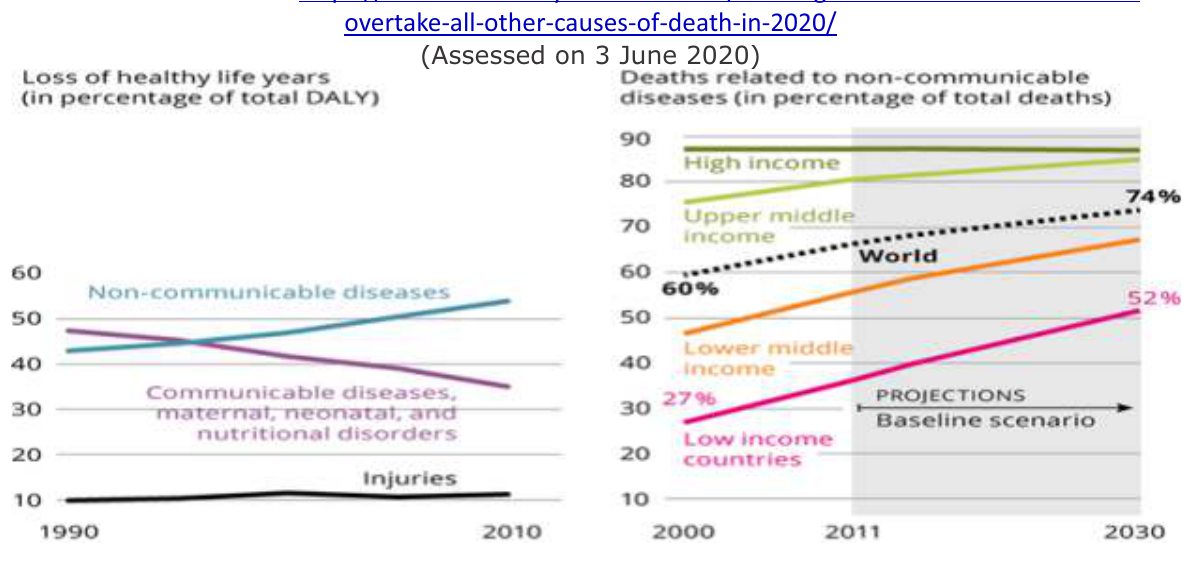
Figure-II: Predicted Shift of Disease Burden in South East